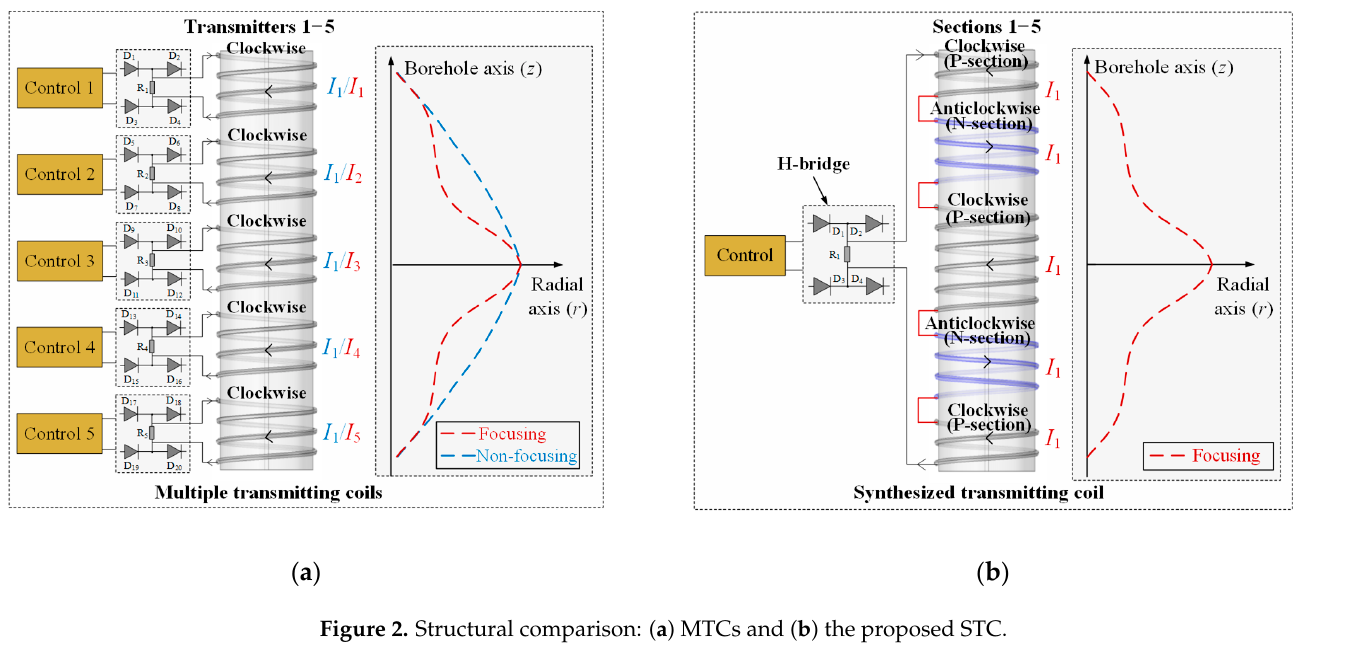
Figure 2. Structural comparison: ( a ) MTCs and ( b ) the proposed STC.